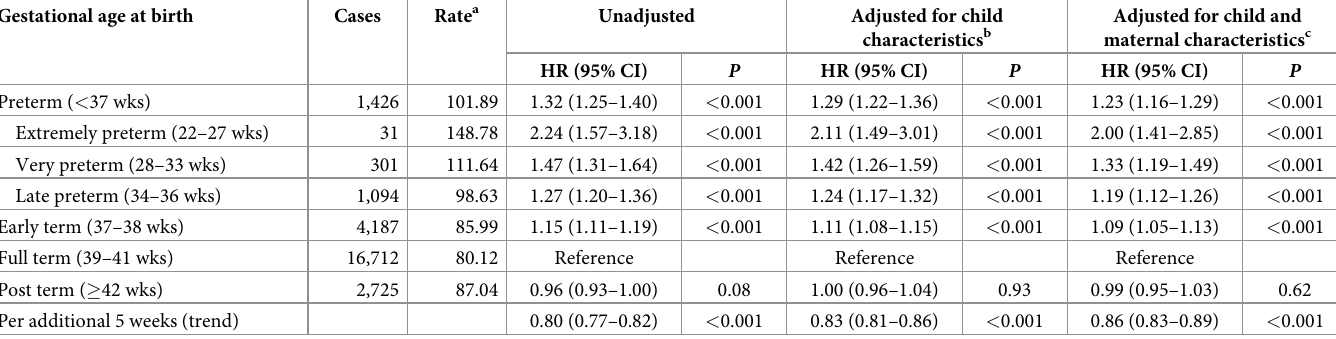
Table 2. Adjusted HRs for lipid disorders associated with gestational age at birth, Sweden, 1973–2016.